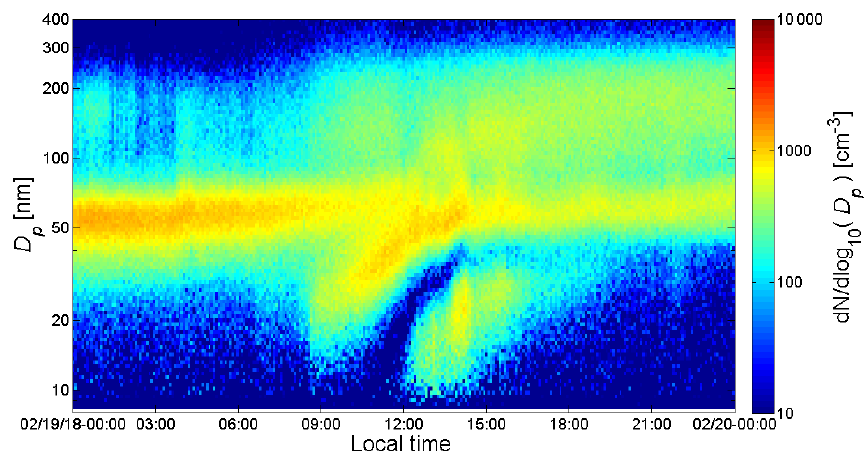
Figure 3. Characteristic examples of two CN < 50 growth events at ATTO on 19 and 20 February 2018. The temporal evolution of the particle number size distribution (PNSD) is shown as a heat map, emphasizing the pronounced Aitken mode as well as particle growth events from the sub-50nm particle to the Aitken mode during daylight.